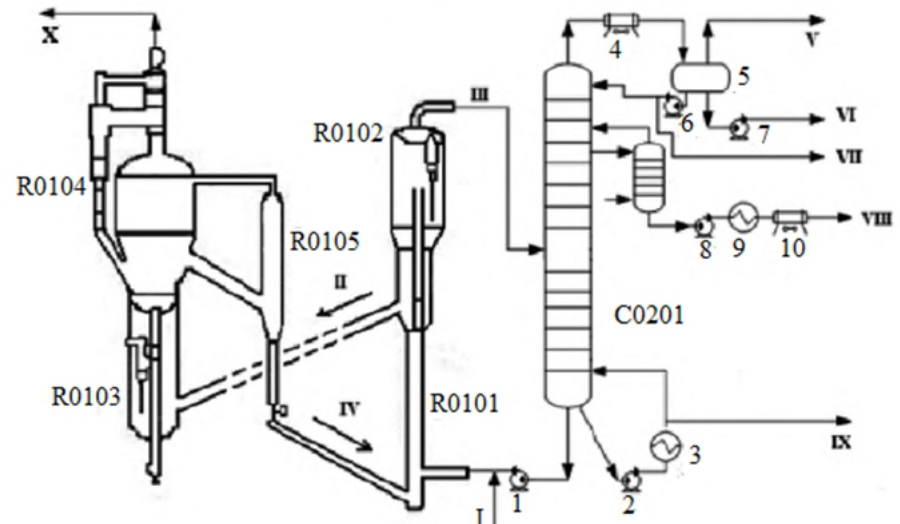
Figure 2. General flow diagram of the catalytic cracking unit (R2R): R0101—riser,